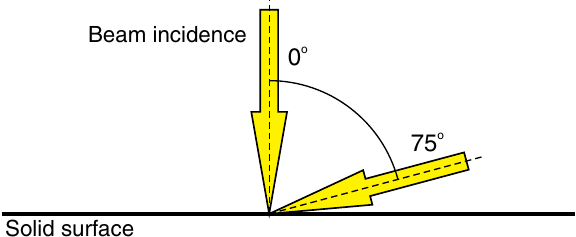
FIG. 14. Two angles of incidence for beams modeled in TRIM .